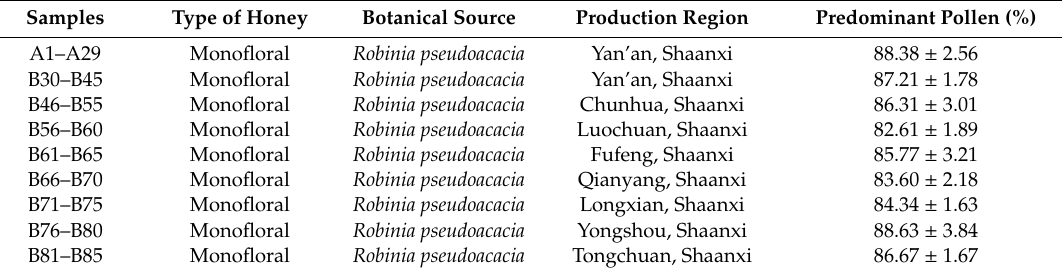
Table 1. Characterization of the analyzed acacia honey